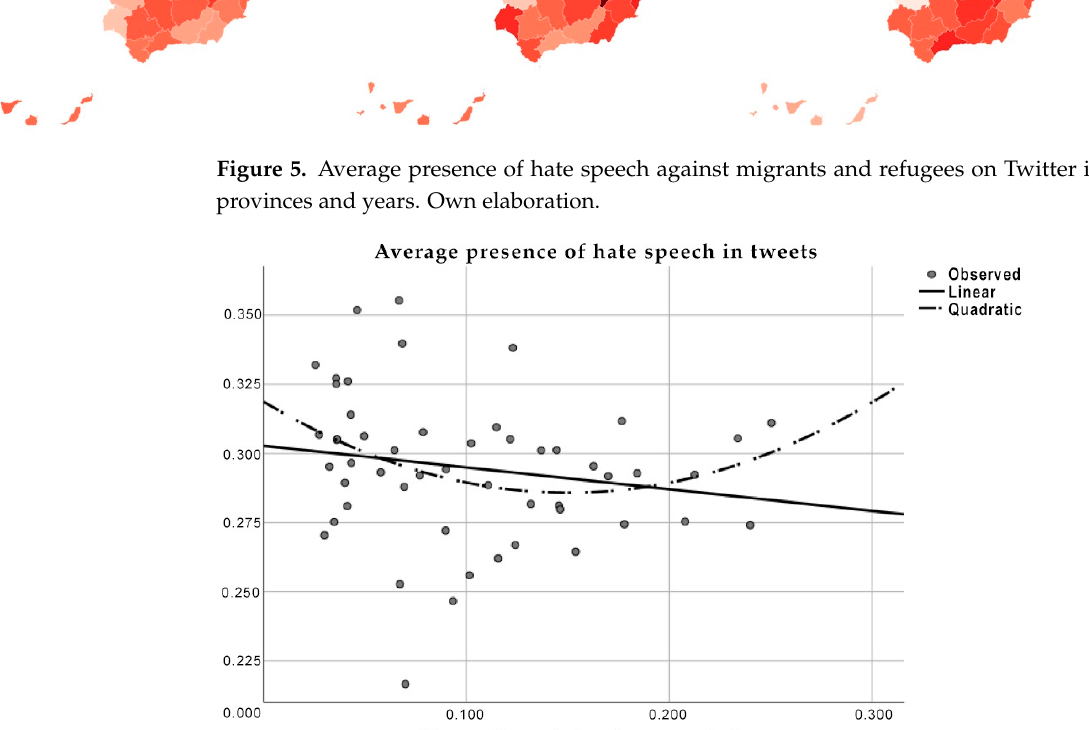
Figure 6. Scatter plot. Correlation between immigrant population and presence of hate speech. Own elaboration.